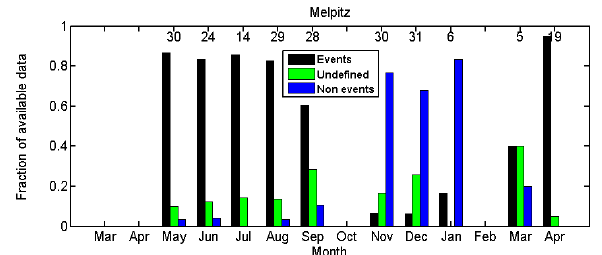
Fig. A8. The fraction of event, undefined and non-event days out of all analyzed days during each month in the year at K-puszta, Hungary, during March 2008–February 2009.